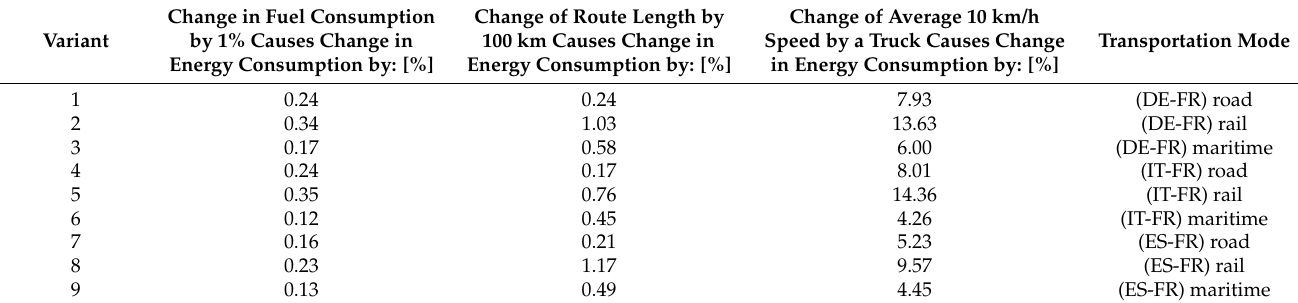
Table 4. Sensitivity analysis of energy consumption for delivery